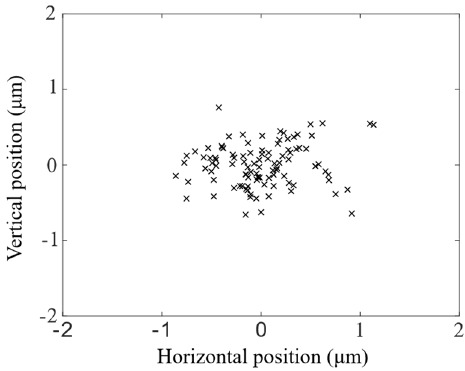
Figure 7. A scatter plot mapping the lateral positions of an optical fibre randomly inserted into an alignment slot 100 times. The alignment slot confined the fibre to within ±0.83 and ±0.52 μ m of the optical axis in the horizontal and vertical axes respectively to two standard deviations.